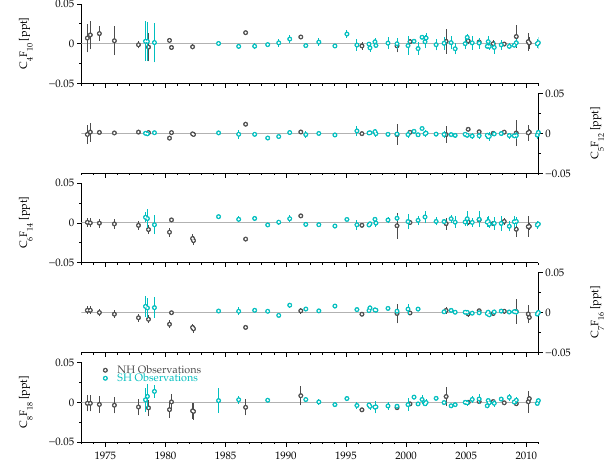
Fig. 5. The mole fraction residuals, taken as the observations mi- nus final modeled mole fractions (Northern Hemisphere – grey and Southern Hemisphere – light blue). The vertical lines represent the uncertainty associated with each observation. A zero line is also plotted for